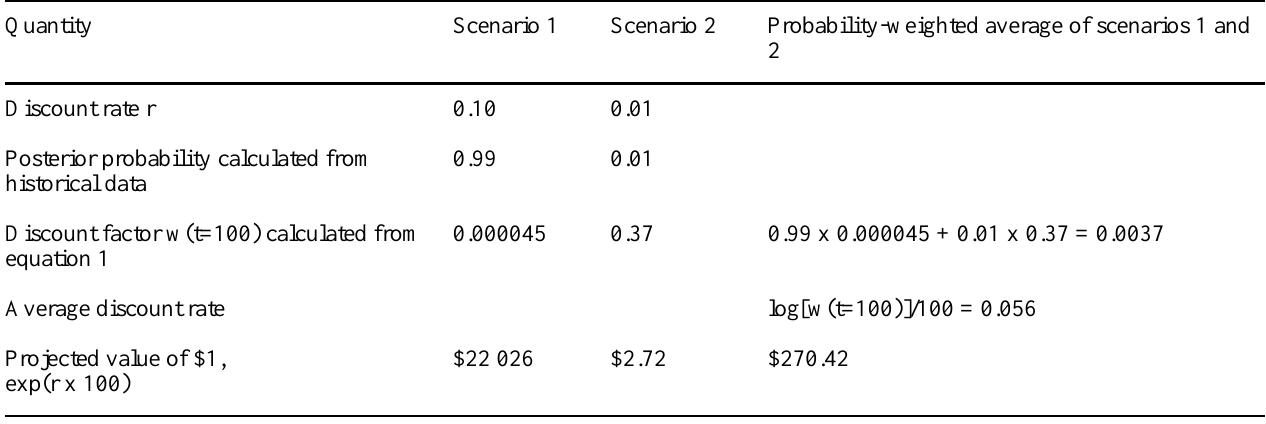
Table 1. Results of simple example projecting the value of an environmental project over 100 years using two scenarios for the discount